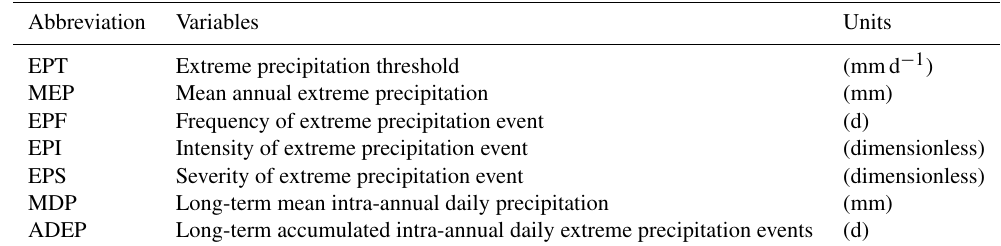
Figure 1. Procedure for the EPT determination of the Xingxian station. (a) The multifractal index α (black dots) and the alternative abrupt points (red dots). (b) Pooled variances (black dots) as calculated from the α series with the significant abrupt points (red dots) of the variances. (c) As in panel (a) but for the singularity γ S . (d) As in panel (b) but for the variance calculated from the γ S series. (e) The time variation of daily precipitation ranging from 1961 to 2015. The blue dotted line represents the determined EPT. Table 1. Variables (abbreviations) used in this study addressing precipitation